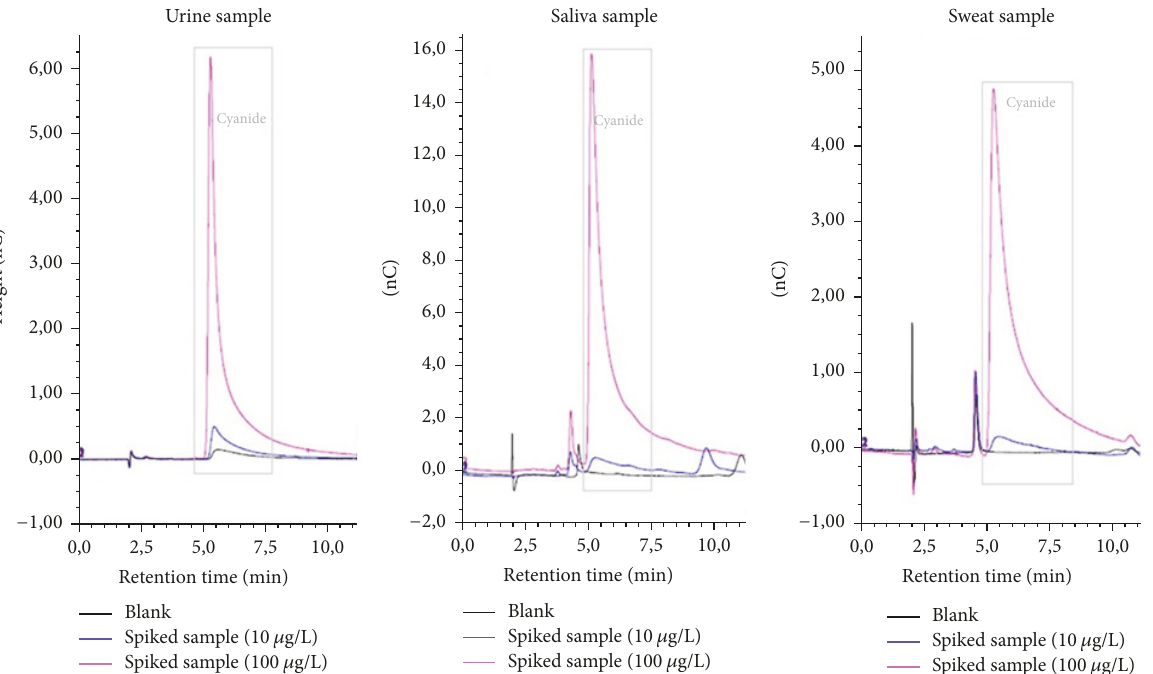
Figure 4: Chromatograms obtained from blank and spiked biological